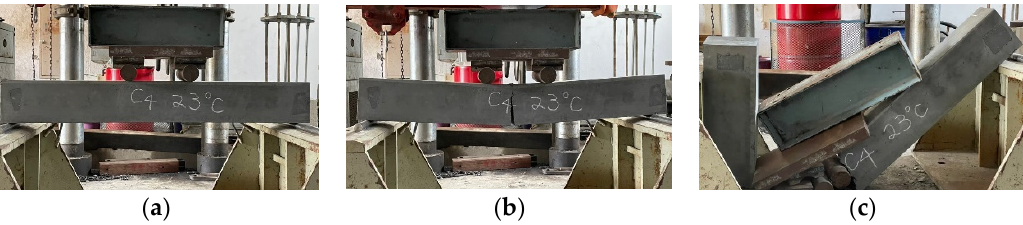
Figure 19. The failure process of the UHPC beam at room temperature: ( a ) elastic stage, ( b ) cracking stage, and ( c ) ultimate stage.